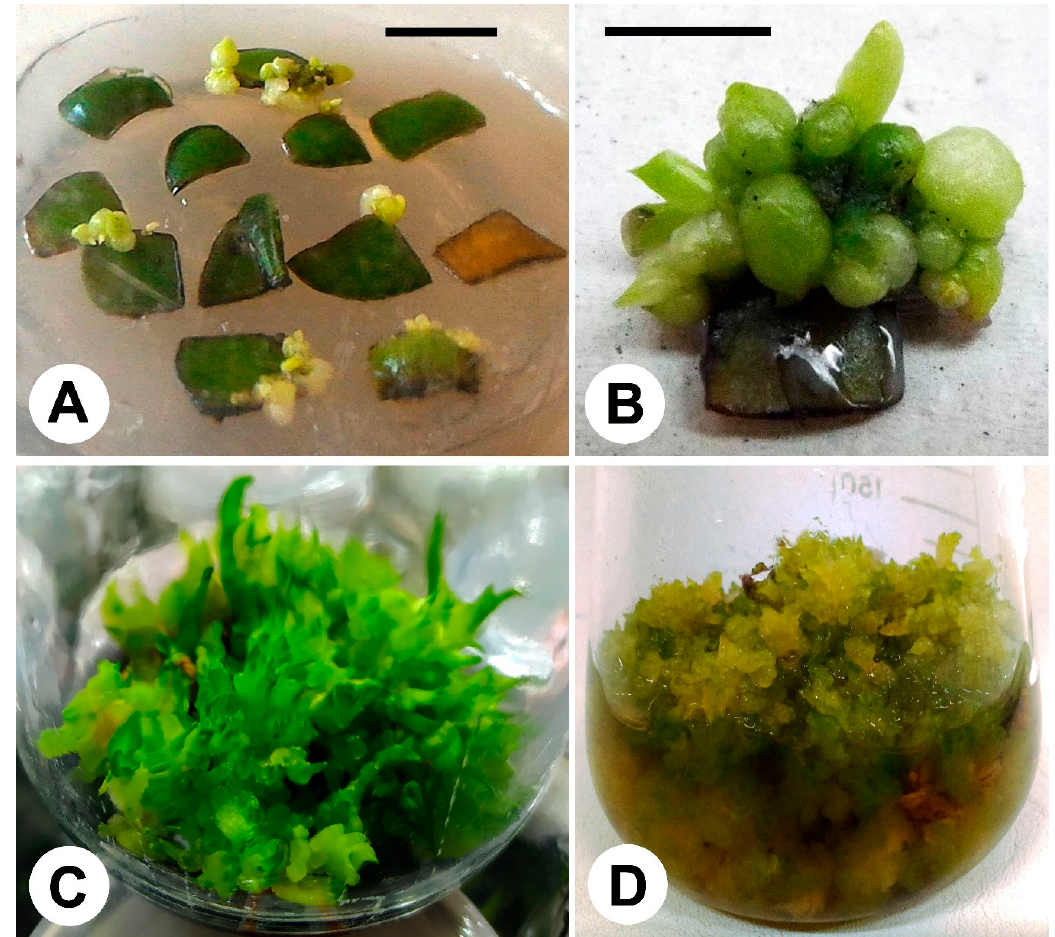
Figure 1. Induction, proliferation and regeneration of protocorm-like bodies in Dendrobium and Phalaenopsis orchids. Protocorm-like bodies (PLBs)-directly induced from leaf segments of Phalaenopsis hybrid ‘501’ (A) obtained from young in vitro shoots from inflorescence nodal segments and details of secondary PLBs ( B ) obtained in New Dogashima Medium (NDM) culture medium. Proliferation of PLBs in agar ( C ) and liquid ( D ) MS½ culture medium of Dendrobium ‘Hybrid 3’. Bars = 1 cm. Unpublished photos of Cesar A. Zanello (A,B) and Jean C. Cardoso (C,D).